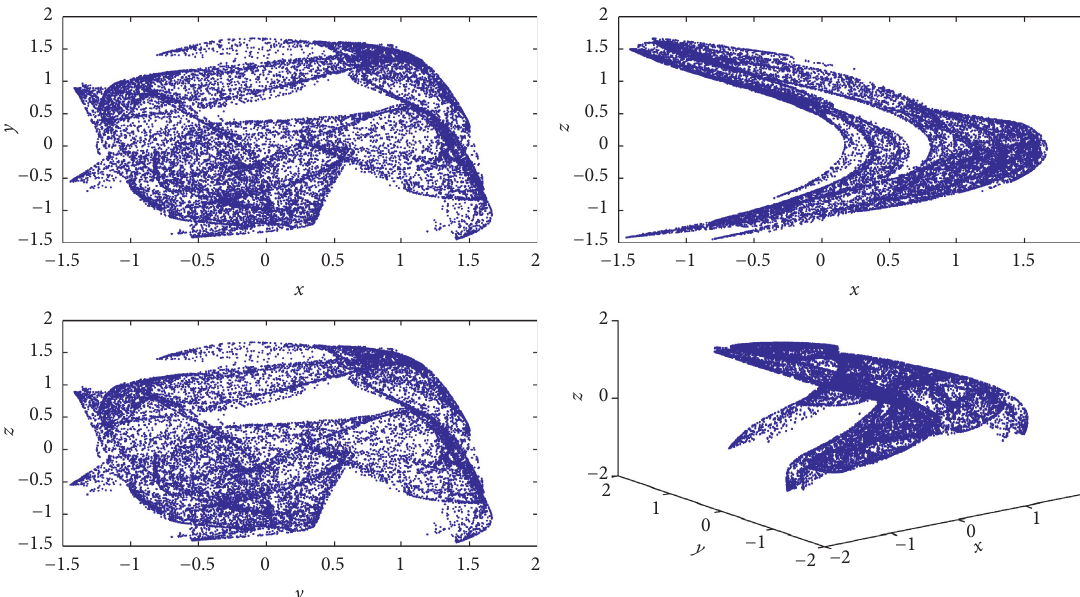
Figure 1: Chaotic attractor of the fractional order Grassi–Miller map for α � 1, β � 0 . 5, and order ] � 0 . 999.